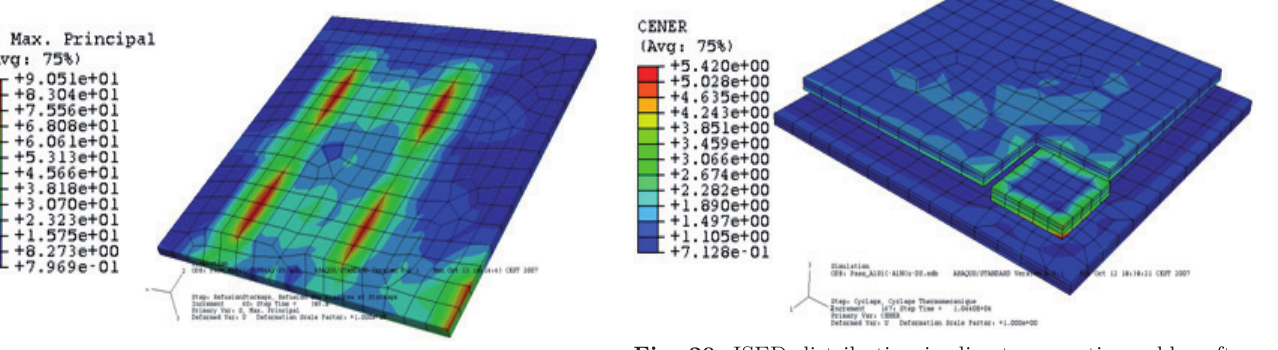
Fig. 20. ISED distribution in direct connection solder after thermal cycling (mJ/mm 3